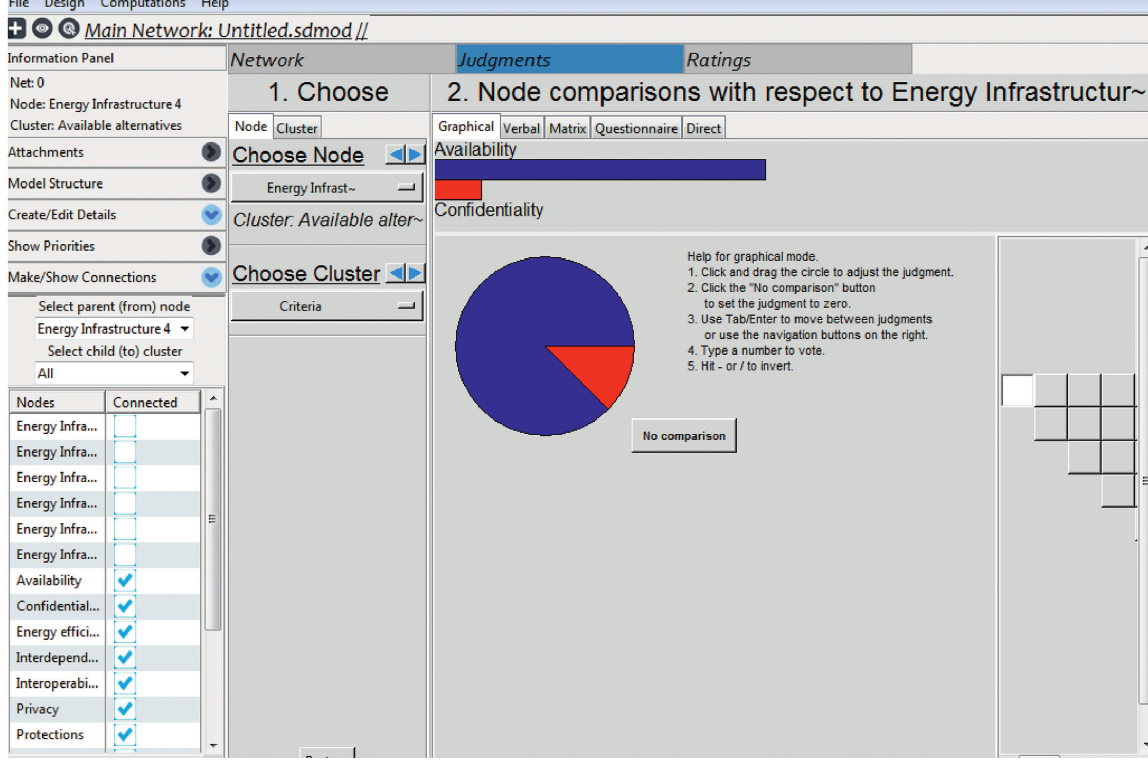
Figure 4: Graphical representation of the comparison for